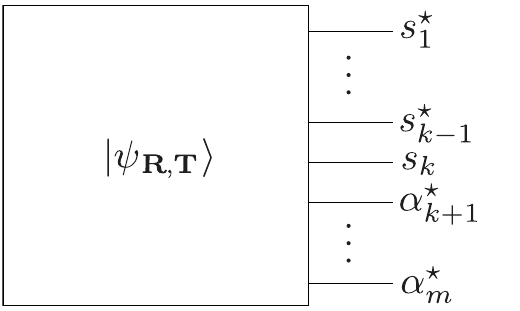
FIG. 1. In step k of the algorithm, we calculate the relative probabilities of obtaining s k photons conditioned on the photon- number outcomes of the previous modes and the heterodyne measurement outcomes of ensuing modes.